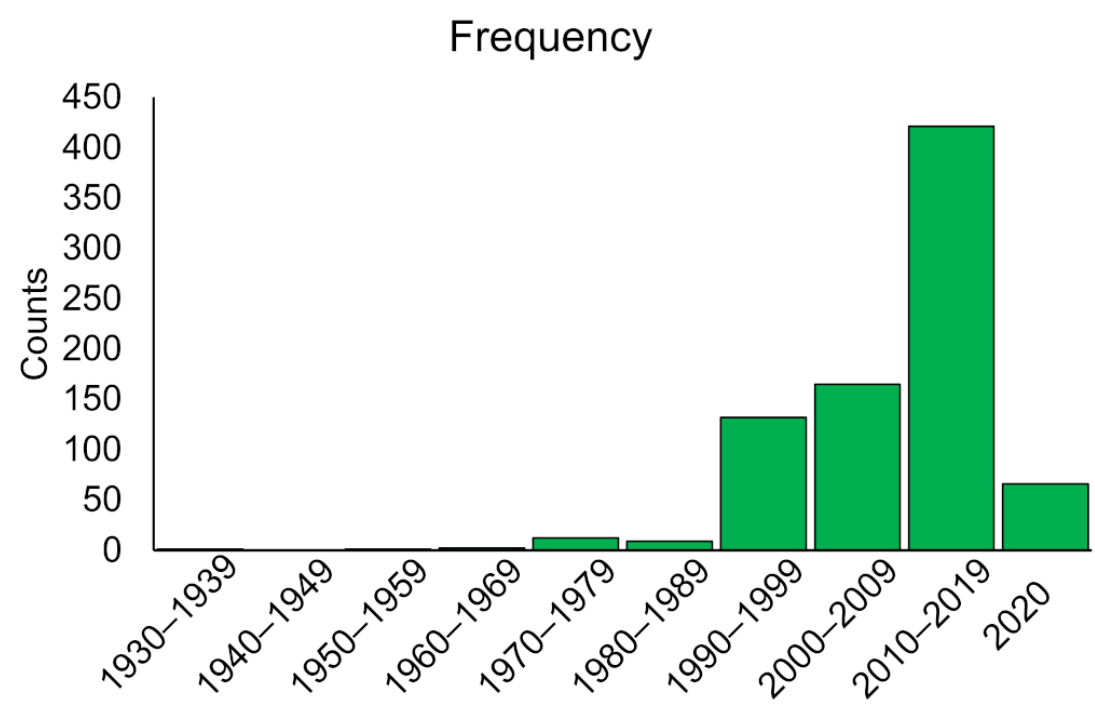
Figure 2. An extended summary of studies based on the systematic literature search in Clarivate Web of Science [1], now with terms agricultural land abandonment, cropland abandonment, old fields, deactivation, deagrarianization, retired fields and post-agrogenic